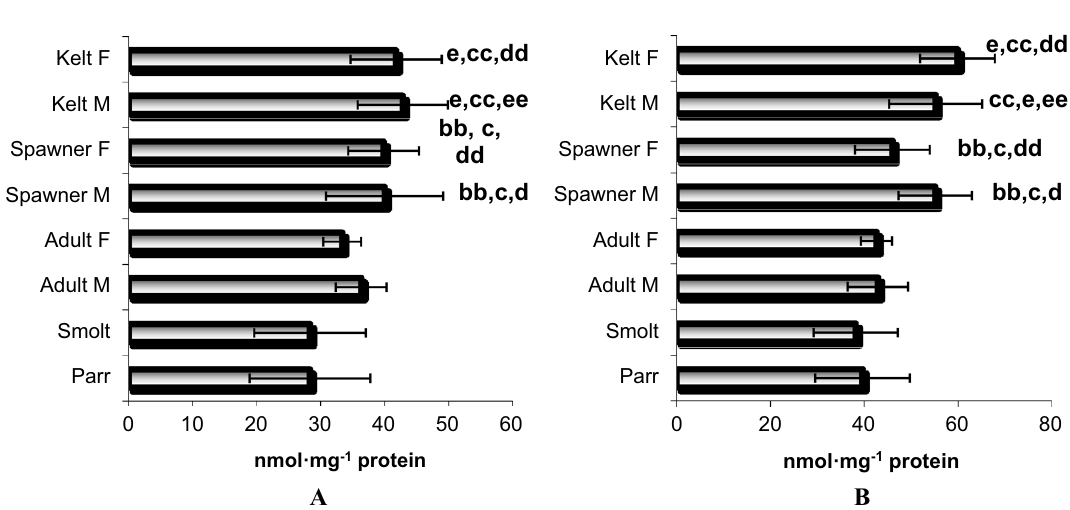
Figure 2. Aldehydic derivatives (AD) (nmol/mg protein) and ketonic derivatives (KD) of oxidatively modified proteins (OMP) (nmol/mg protein) content in the muscle tissue of the sea trout ( Salmo trutta m. trutta L.) during different development stages. Results are expressed as mean ± S.D. Differences between experimental groups were analysed by one-way ANOVA and Tukey’s post-hock test for unequal observations. Differences were considered significant at p < 0.05. Legend: developmental stages—Parr (n = 113), Smolt (n = 122), Adult Male (n = 13) and Adult Female (n = 12), Spawner Male (n = 33) and Spawner Female (n = 55), Kelt male (n = 12) and Kelt Female (n = 12). Significant differences between groups are designated as follows: a—Smolt group vs. Parr group; aa—Adult Male or Adult Female vs. Parr group; b—Adult Male or Adult Female vs. Smolt group; bb—Spawner Male group or Spawner Female group vs. Parr group; c—Spawner Male group or Spawner Female group vs. Smolt group; cc—Kelt Male group or Kelt Female group vs. Smolt group; d—Spawner Male group